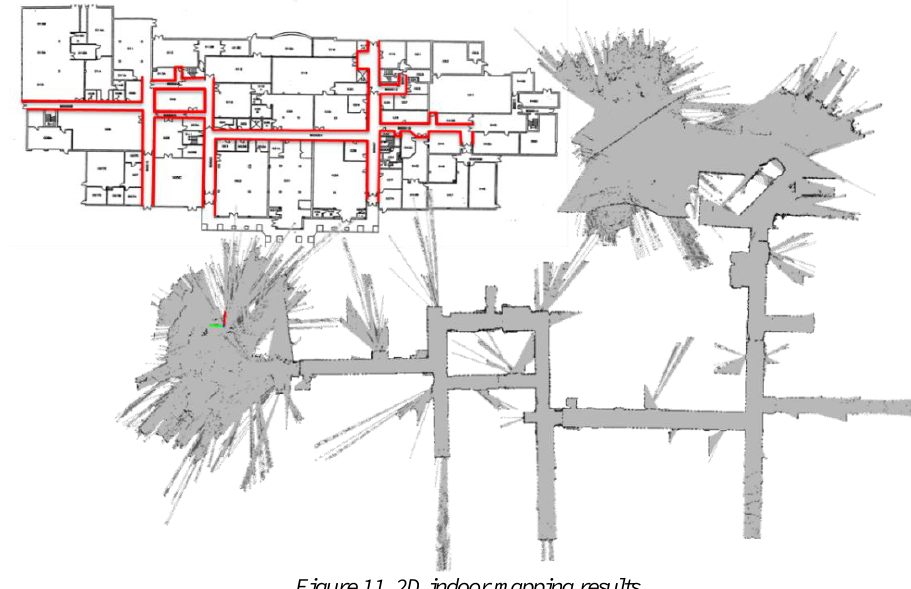
Figure 11. 2D indoor mapping